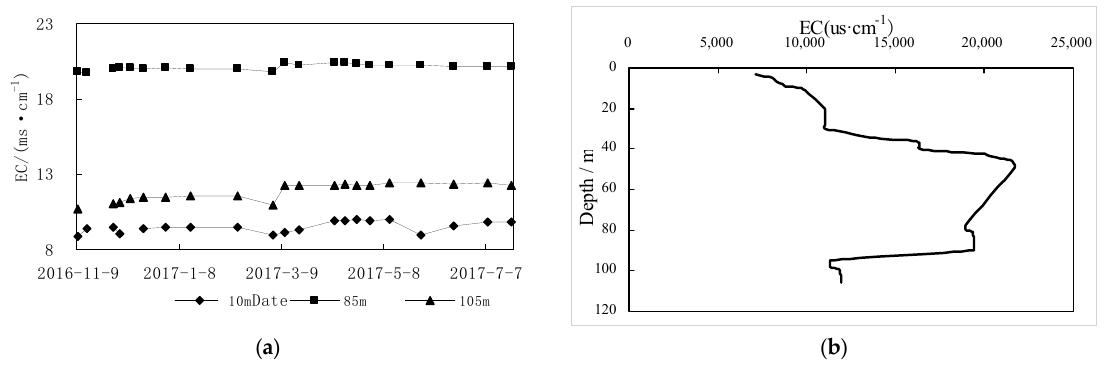
Figure 5. The conductivity and dynamic diagram of groundwater of different depths ( a ) Dynamic curve of electrical conductivity at different depths; ( b ) Vertical conductivity distribution diagram of vertical depth).